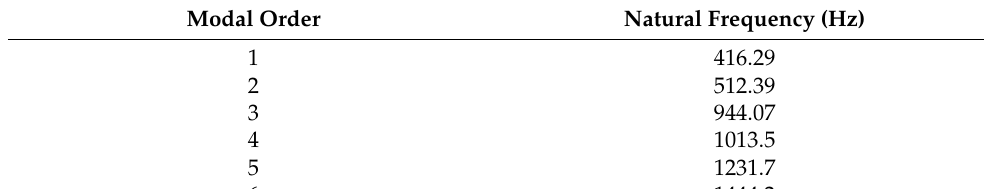
Table 8. The natural frequencies of order 1–6 of the specimen.